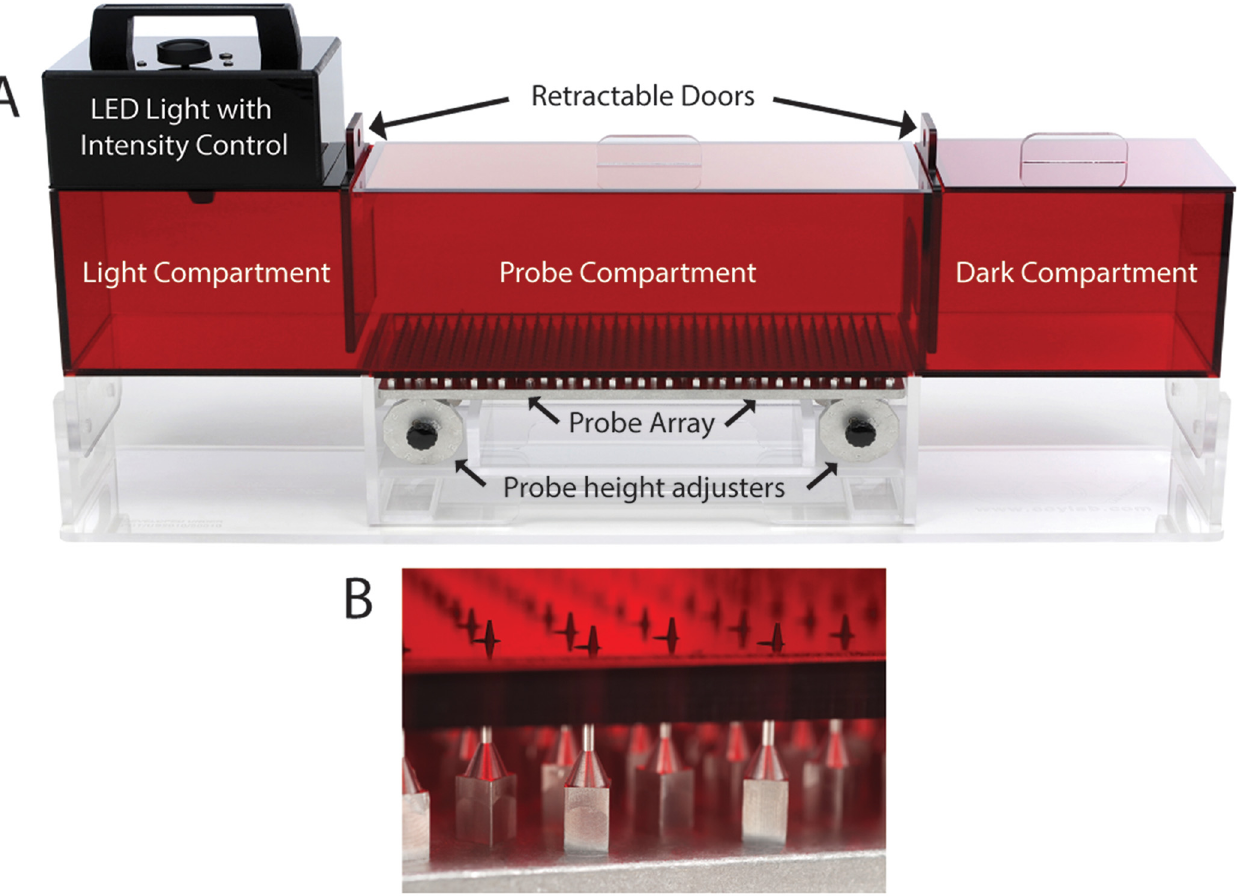
Fig 1. Mechanical Conflict System. Panel A shows a front view of the complete Mechanical Conflict System highlighting key components of the apparatus. Panel B shows a close-up of the nociceptive probe array with probes extended above the probe compartment